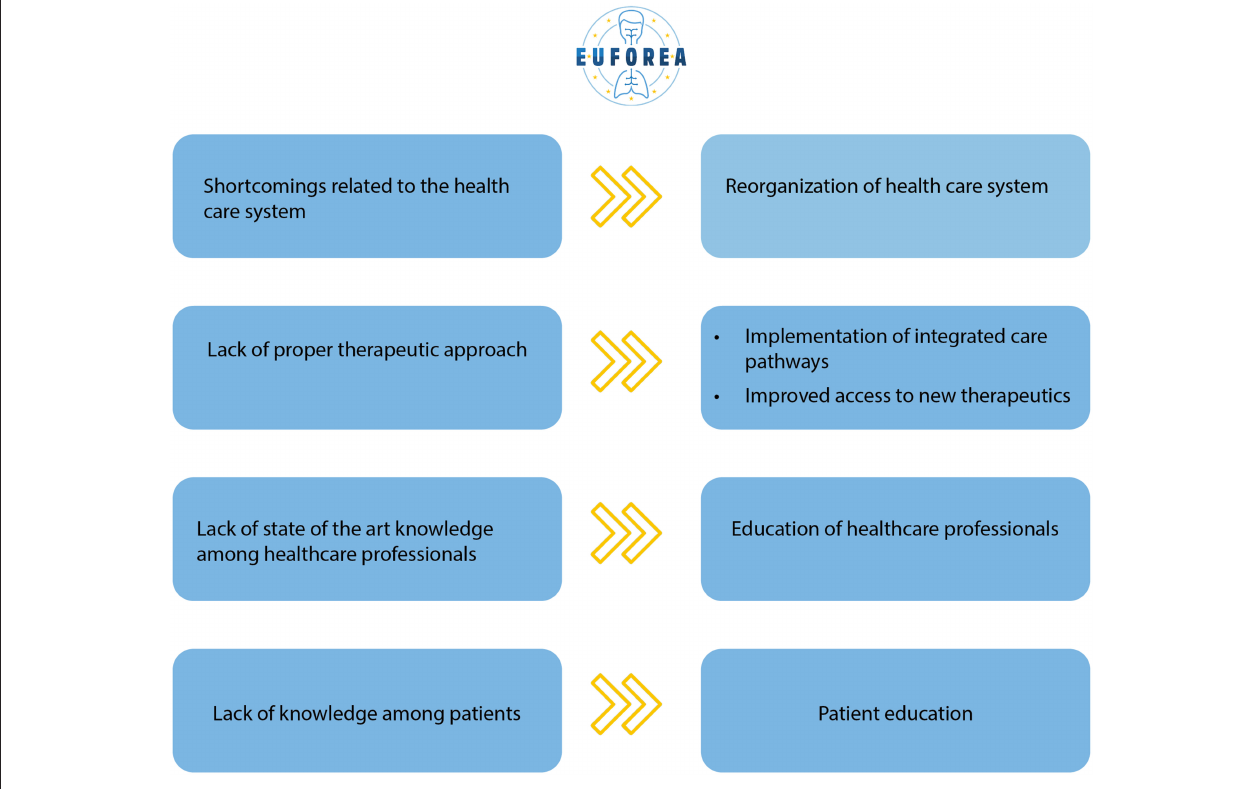
and opinions, is a very important step in the pursuit of personalized